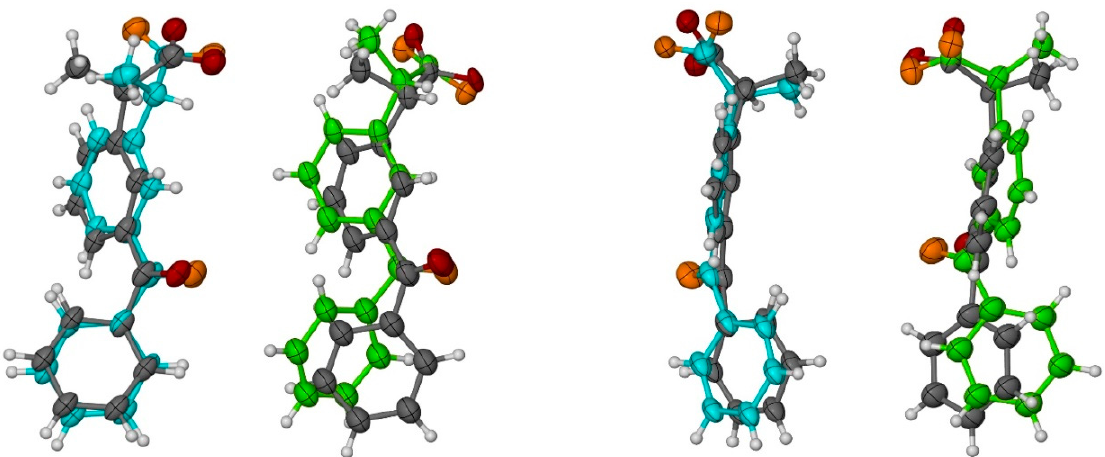
Figure 5. Two views of ketoprofen (KP) conformations of molecules A (blue) and B (green) observed in the crystal structure. The less occupied conformations (C,D, respectively) are shown in grey. Oxygen atoms in molecules A and B are shown in orange. All non-H atoms are shown as 50% probability ellipsoids.